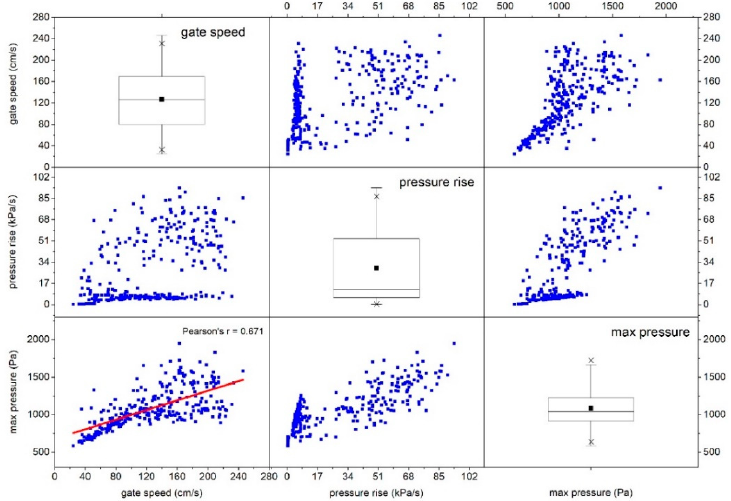
Figure A2. The matrix presenting the relationship between maximum pressure, pressure rise rate, and gate speed at